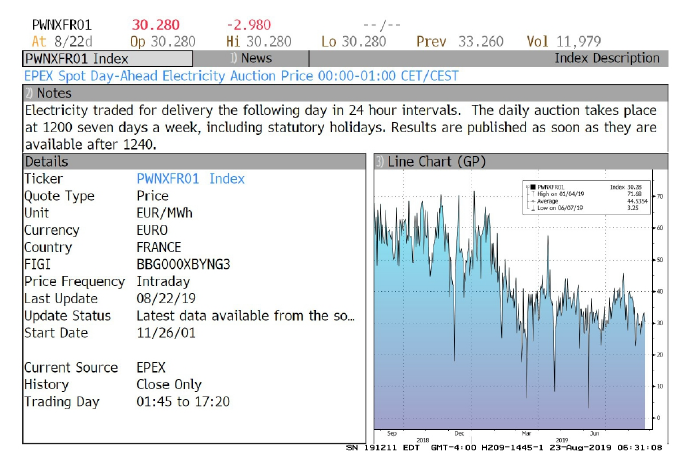
Figure 1. Ticker Bloomberg: PWNXFR 01 (accessed on 23 August